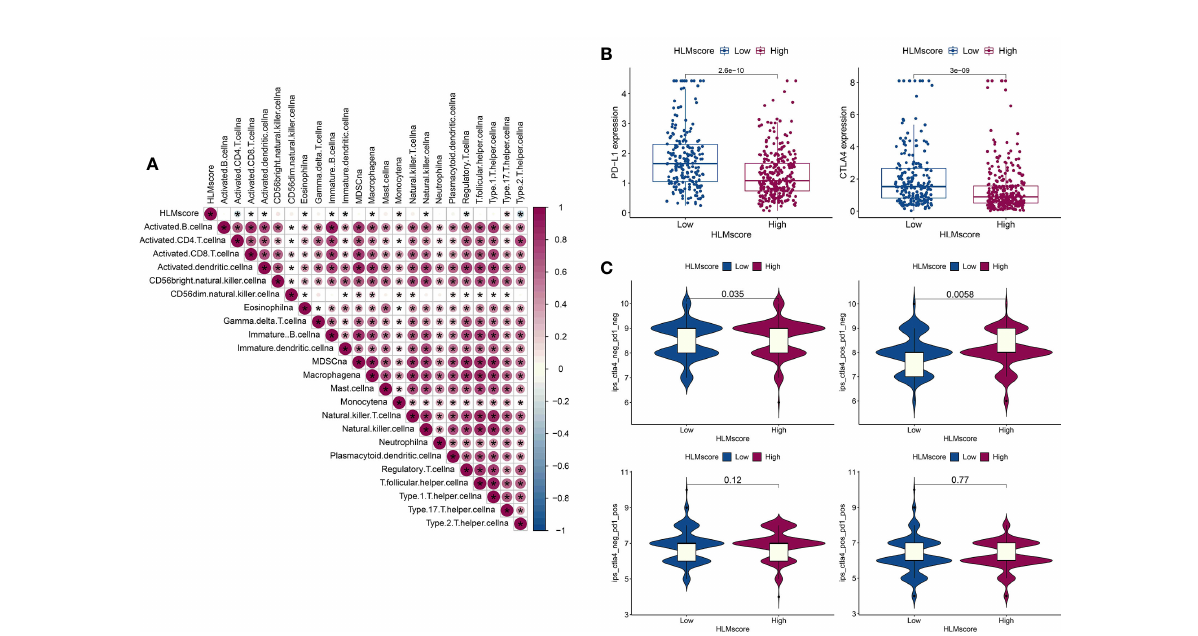
FIGURE 9 Characteristics of the HLMscore status in PCa with an immune-related microenvironment. (A) Correlation analysis between the HLMscore and in fi ltrating immune cell type in TCGA-PRAD. Red, positive correlation, blue, negative correlation.*P < 0.05. (B) The expression levels of PD-L1 and CTLA4 in the two HLMscore groups are shown as boxplots. (C) The IPS scores in ips_ctla4_neg_pd1_neg (CTLA4 and PD1 negative response), ips_ctla4_pos_pd1_neg (CTLA4 positive and PD1 negative response), ips_ctla4_neg_pd1_pos, and ips_ctla4_pos_pd1_pos in relation to the respective HLMscore groups are shown as violin plots. The P values of the Wilcoxon test are shown in the violin